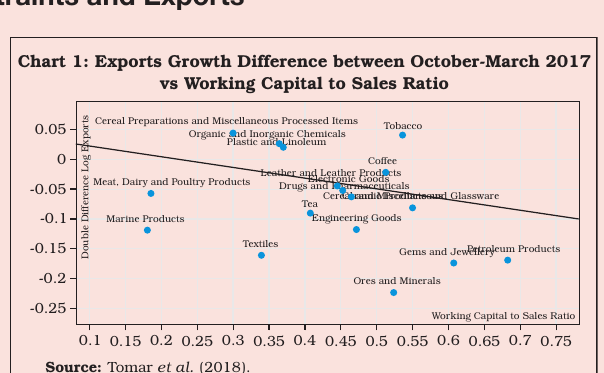
Source: Tomar (2018). et al.